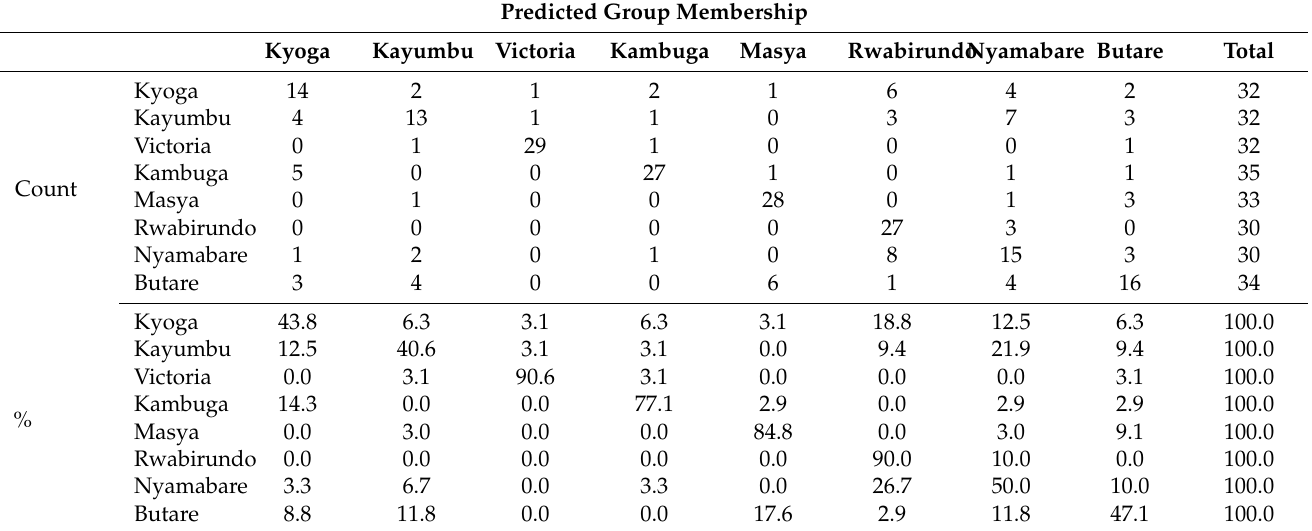
Table 4. Classification Results for all the populations.